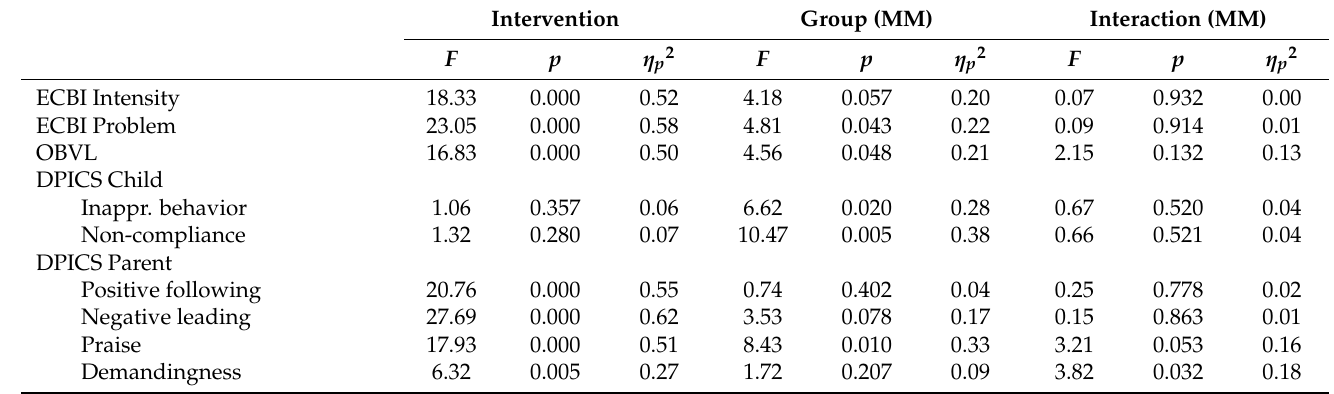
Table 2. PCIT-Home repeated measures ANOVA results ( F -values, p , partial eta squared ( η p 2 )). Intervention